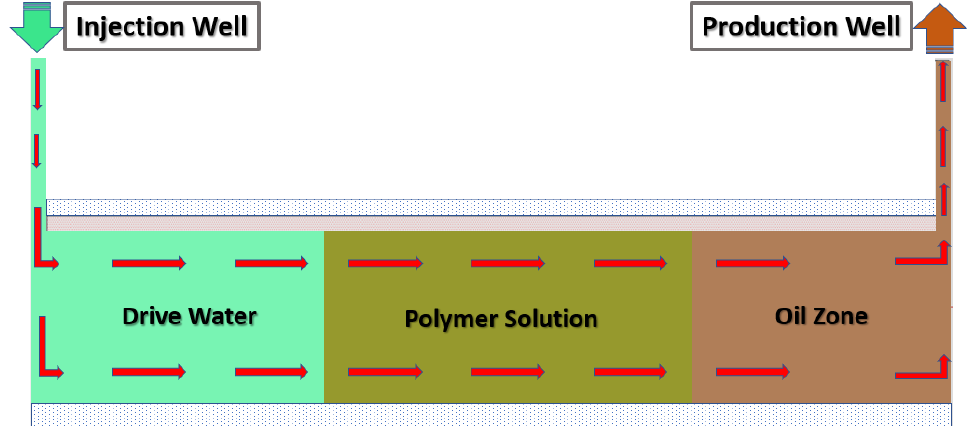
Figure 2. Illustration of a typical polymer-based chemical-enhanced oil recovery (cEOR)